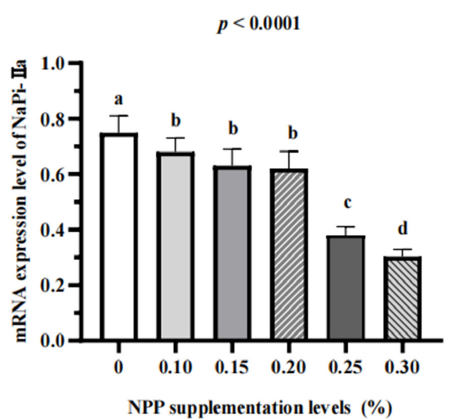
Figure 5. E ff ect of the level of dietary NPP supplementation on the expression of phosphorus trans- porters type IIa Na/Pi cotransporter (NaPi- Ⅱ a) in the kidneys of Hy-Line Brown laying hens